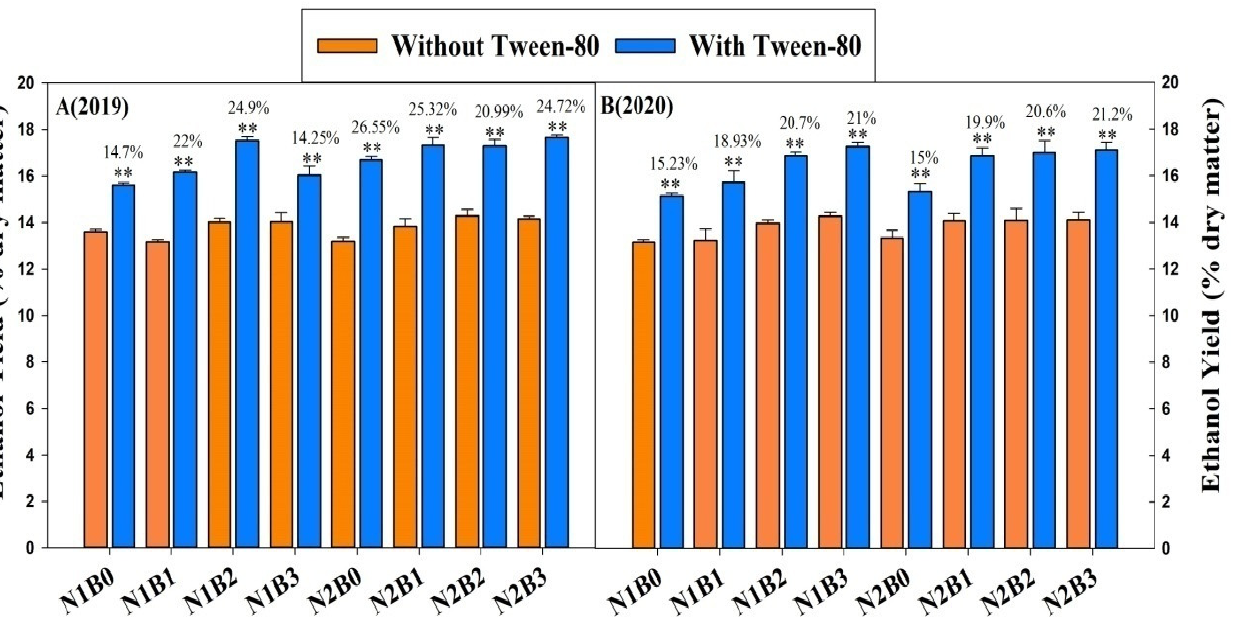
Figure 2. Changes in hexose yields (% cellulose) released with tween ( A ) and without tween ( B ) of rice straw treated with biochar and nitrogen fertilizers. Different letters on bars are not significantly different at p < 0.05. (n = 3).